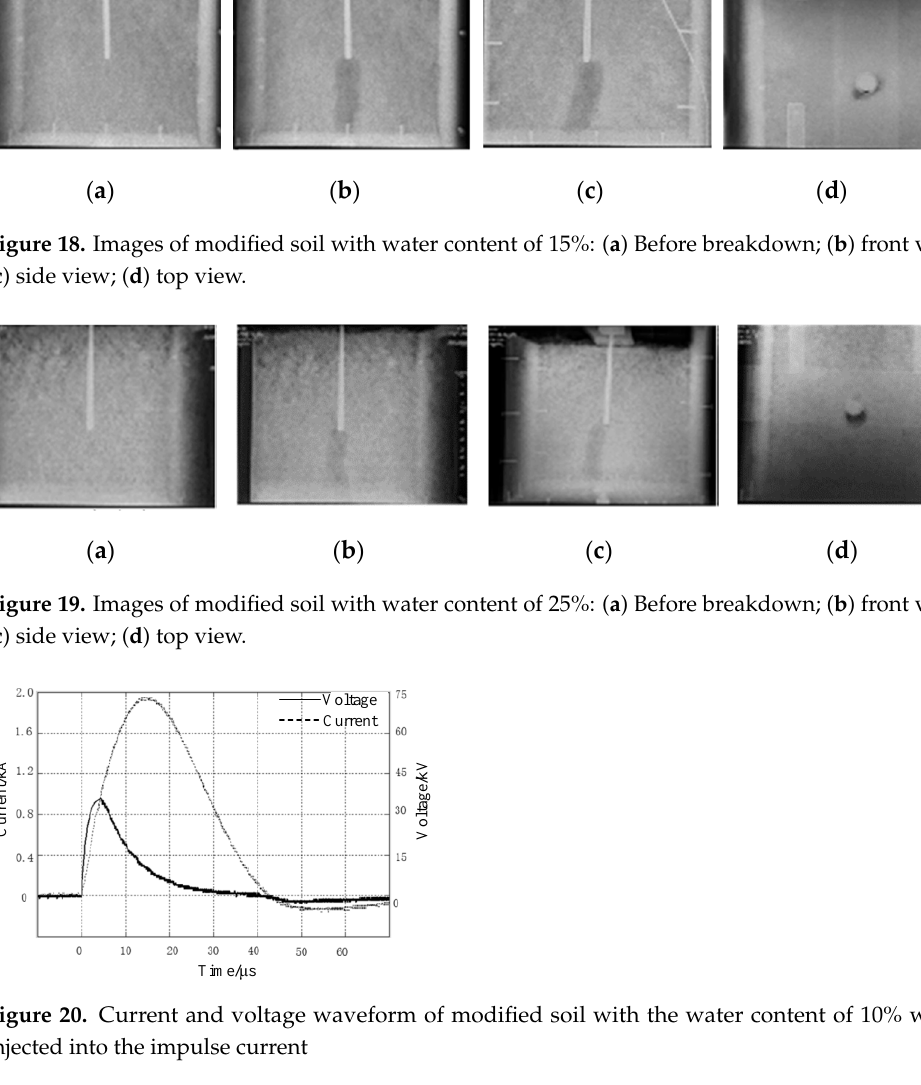
Figure 17. Images of modified soil with water content of 10%: ( a ) Before breakdown; ( b ) front view; ( c ) side view; ( d ) top view.